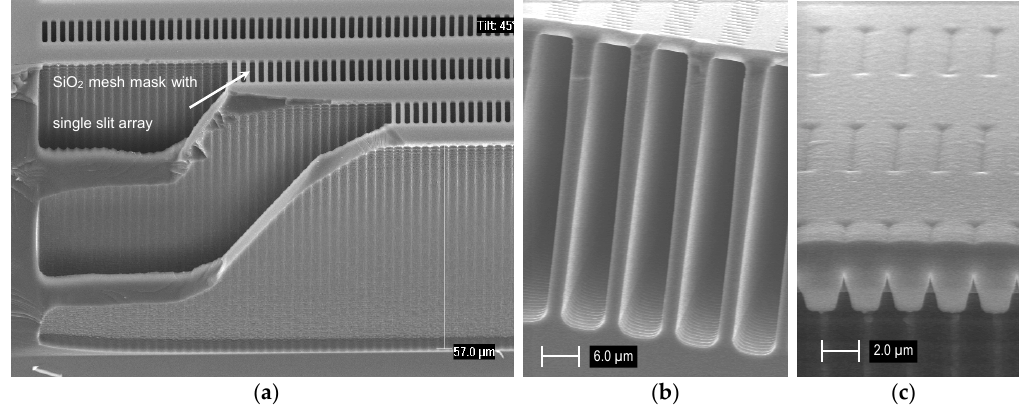
Figure 2. SEM image of 6 µm wide and 57 µm deep vertical microchannels etched through an oxide mesh mask in a single-step DRIE process: ( a ) cross-section through channels with preserved thin silicon dioxide mesh mask; ( b ) cross-section through a row of parallel channels after sealing them with PECVD SiO 2 ; ( c ) cross-section through a sealing of an embedded channel.